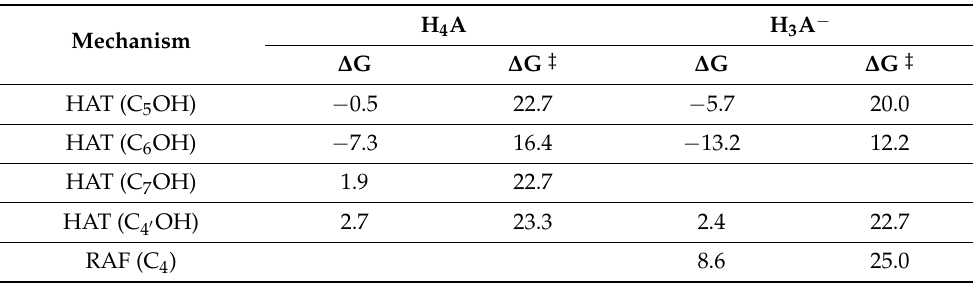
Table 3. Gibbs free reaction energy ( ∆ G) and activation ( ∆ G ‡ ) in kcal/mol at 298.15 K for the considered mechanisms in a water environment.